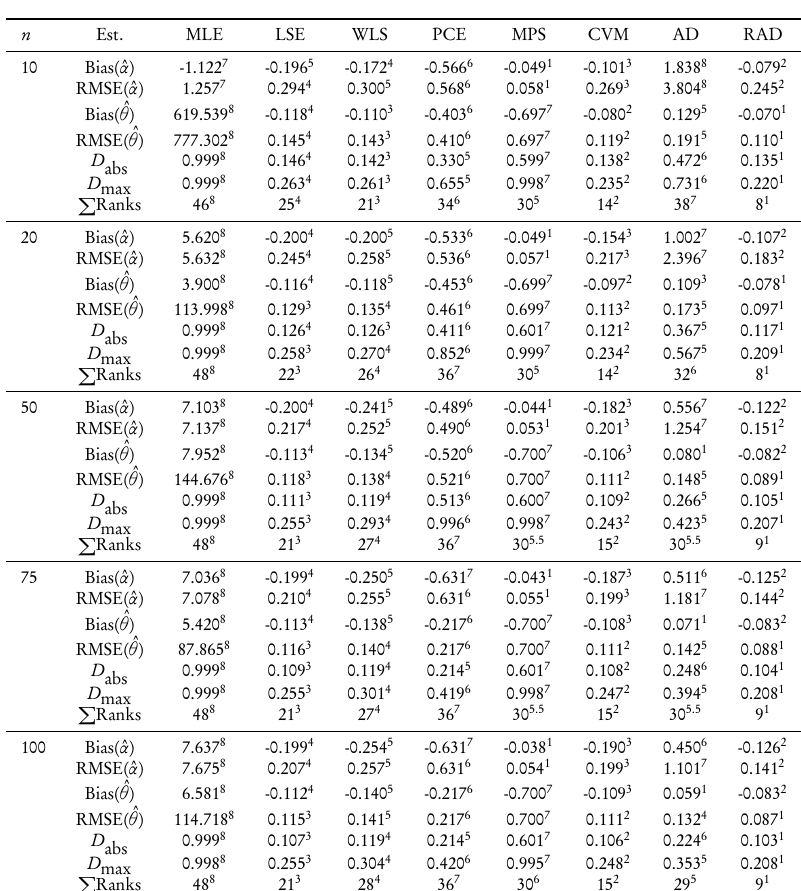
Simulation results for α = 1 , θ = 0.7 and λ = 1